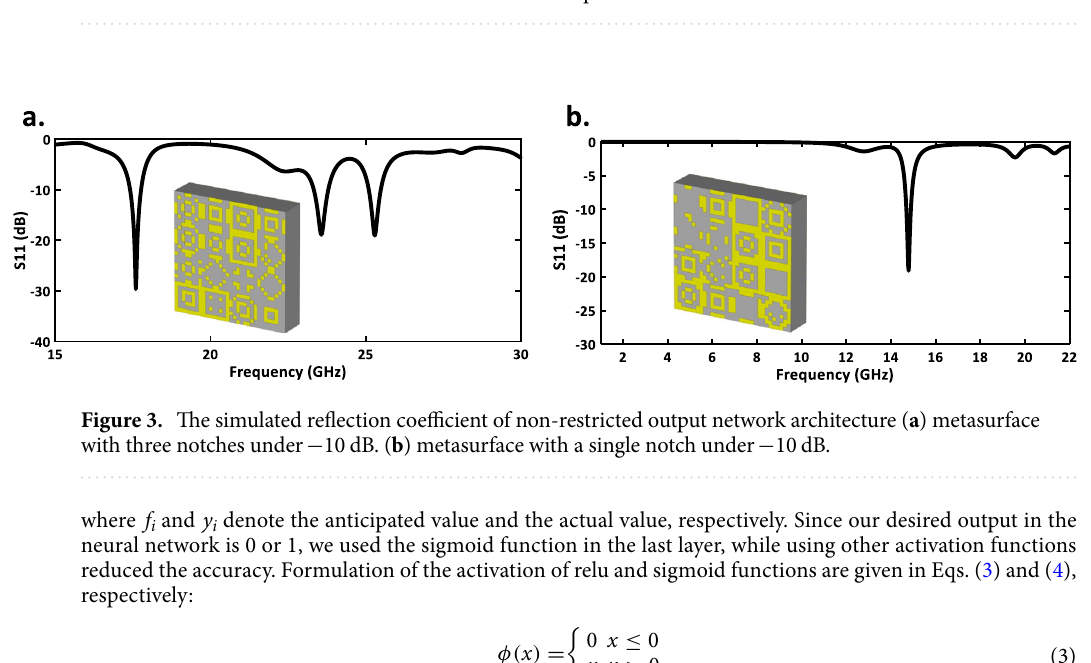
Table 1. Detailed information of the non-restricted output network architecture.